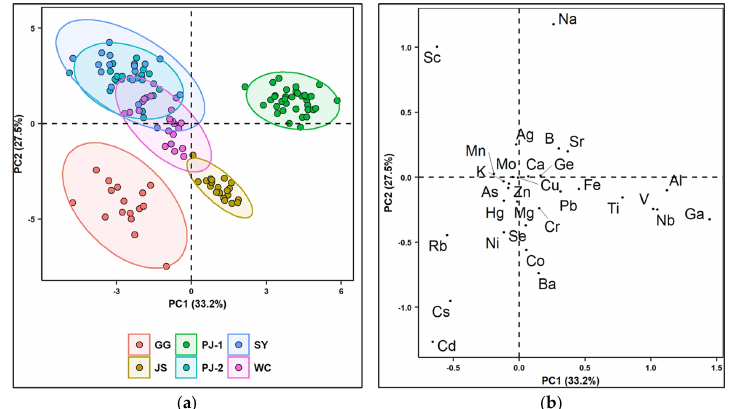
Figure 8. Plots with the results of PCA analysis of the measured analytes. ( a ) Resulting scoring diagram of the 1st and 2nd PCs; ( b ) Loading diagram of all analytes for the first two PCs. Figure is reprinted with permission from Ref. [172].